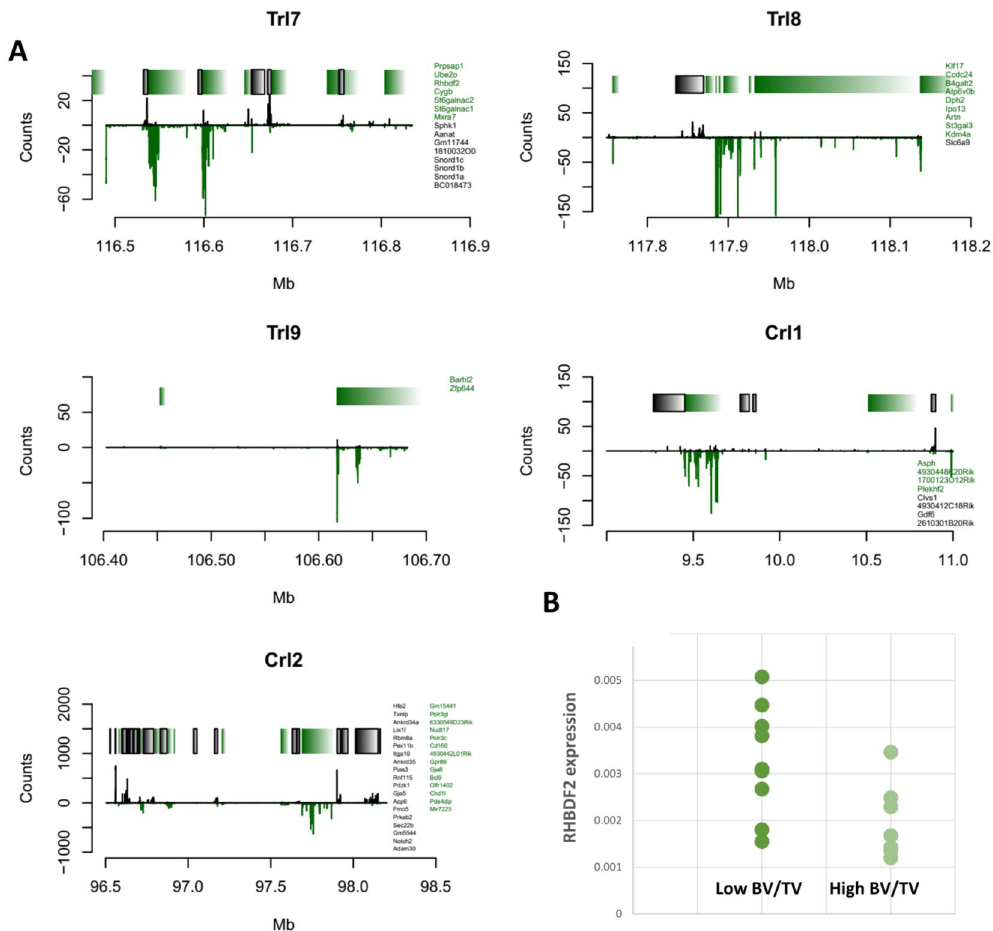
Figure 5. ( A ) RNA-seq of osteoclasts. Gene names are displayed on the right of each plot. Green represents plus-stranded genes; black represents minus-stranded genes. The y-axis represents the raw expression count, where the negative scale refers to the minus-stranded gene count. Each bracket corresponds to a particular gene; left-to-right green (black) brackets fit green (black) top-to-bottom gene names. ( B ) mRNA expression in the femur of male mice. mRNA expression values for Rhbdf2 were normalized against Gadph from two of each extreme BV/TV group, 2 lines with low (bold) and 2 with high (light green); Rhbdf2 expression in the low BV/ TV lines was significantly higher than in the high BV/TV lines, p = 0.005, t-test, n = 9 and 7, respectively.